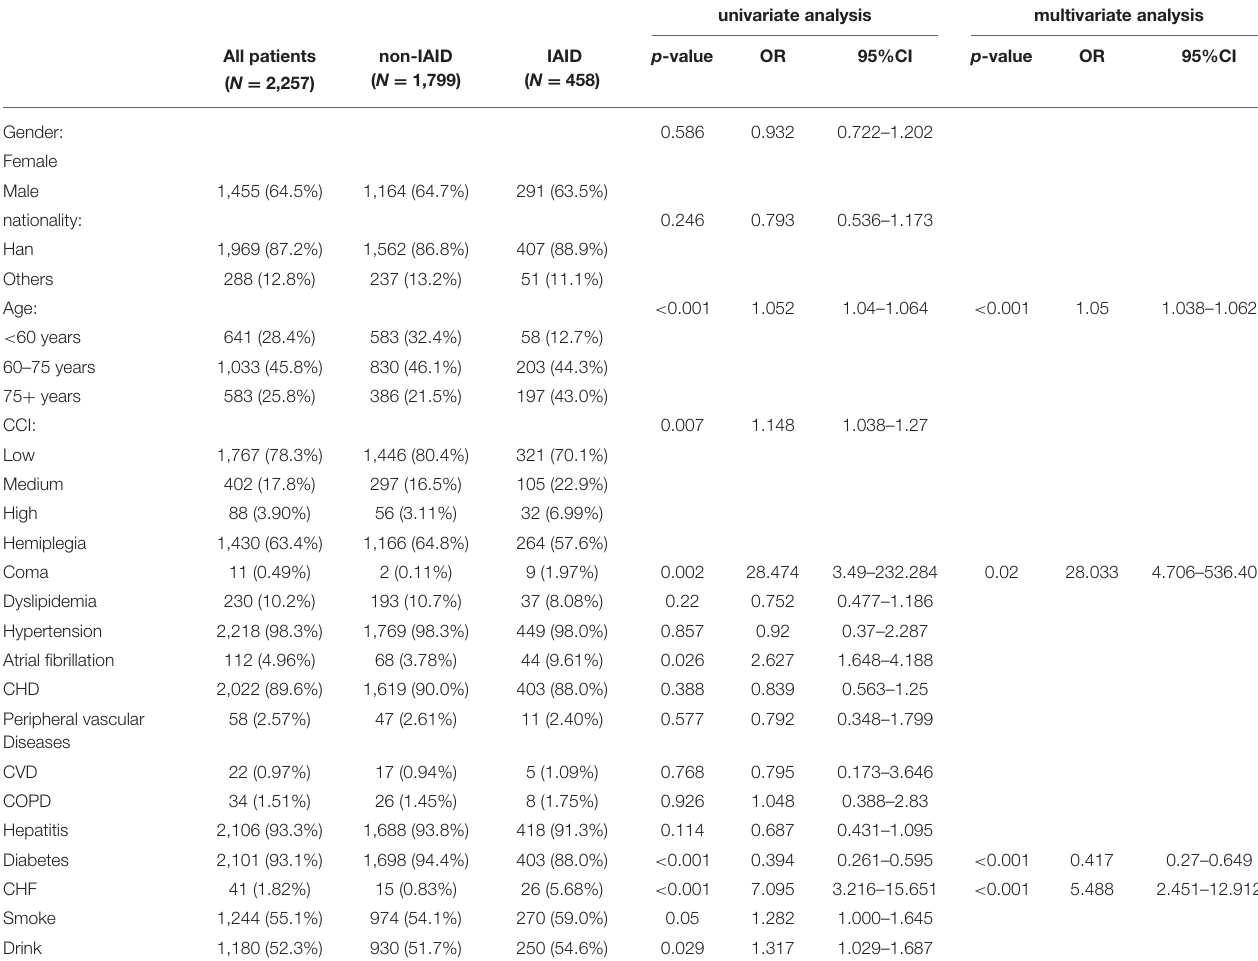
TABLE 1 | Summary statistics of patient characteristics between the IAID and non-IAID